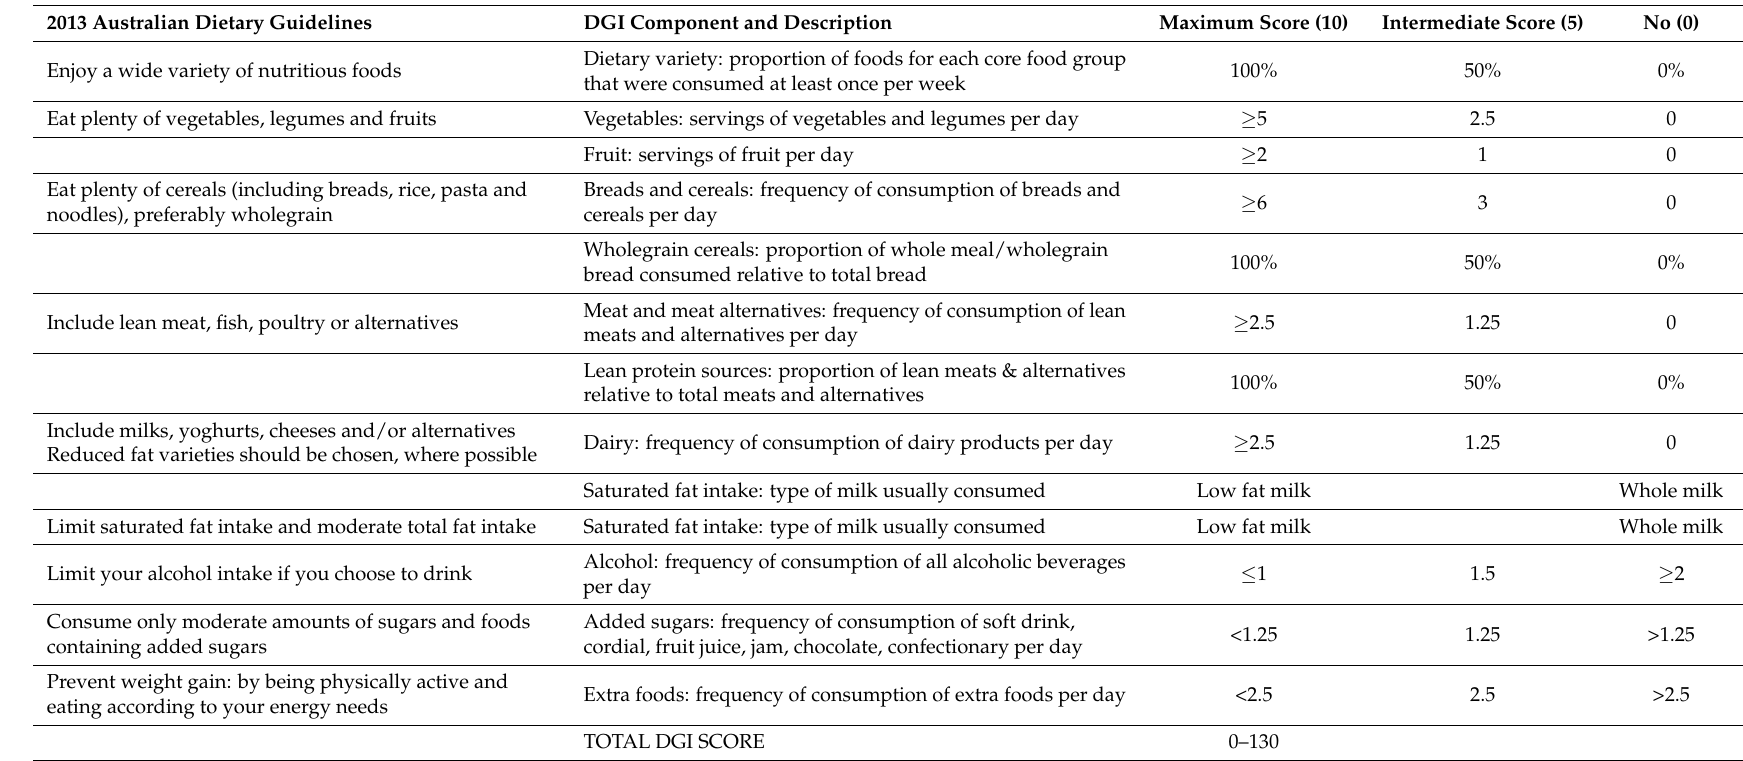
Table 1. Modified version of the Dietary Guideline Index